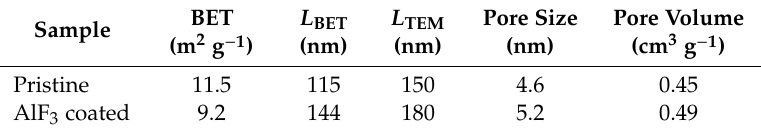
Figure 5. N 2 adsorption desorption isotherm and Barrett–Joyner–Halenda (BJH) pore-size distribution for ( a ) pristine and ( b ) AlF 3 -coated Li 1.2 Ni 0.2 Mn 0.6 O 2 oxides.